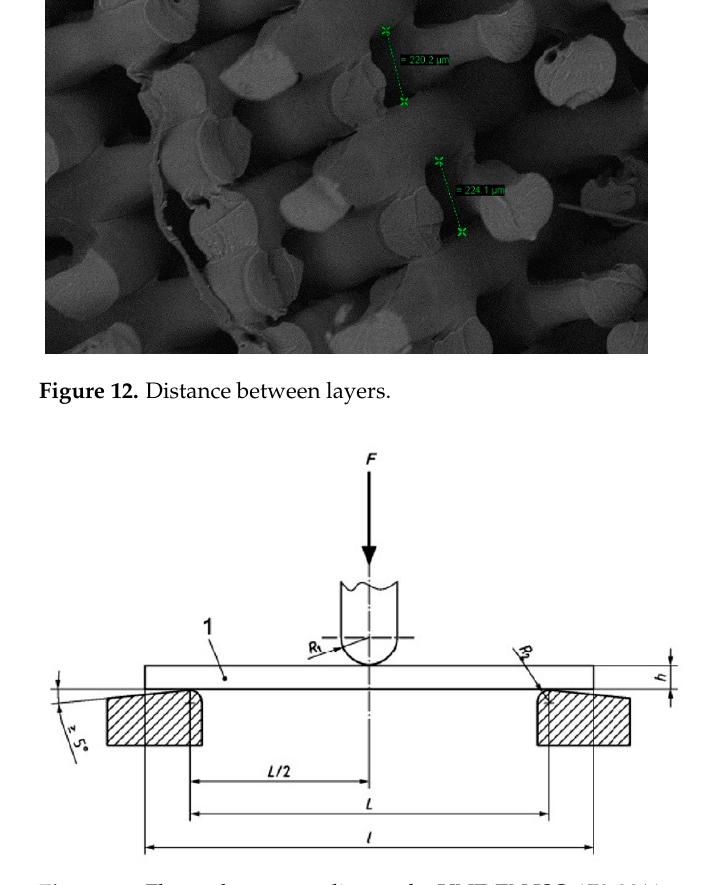
Figure 13. Flexural test according to the UNE-EN ISO 178-2011 normative.